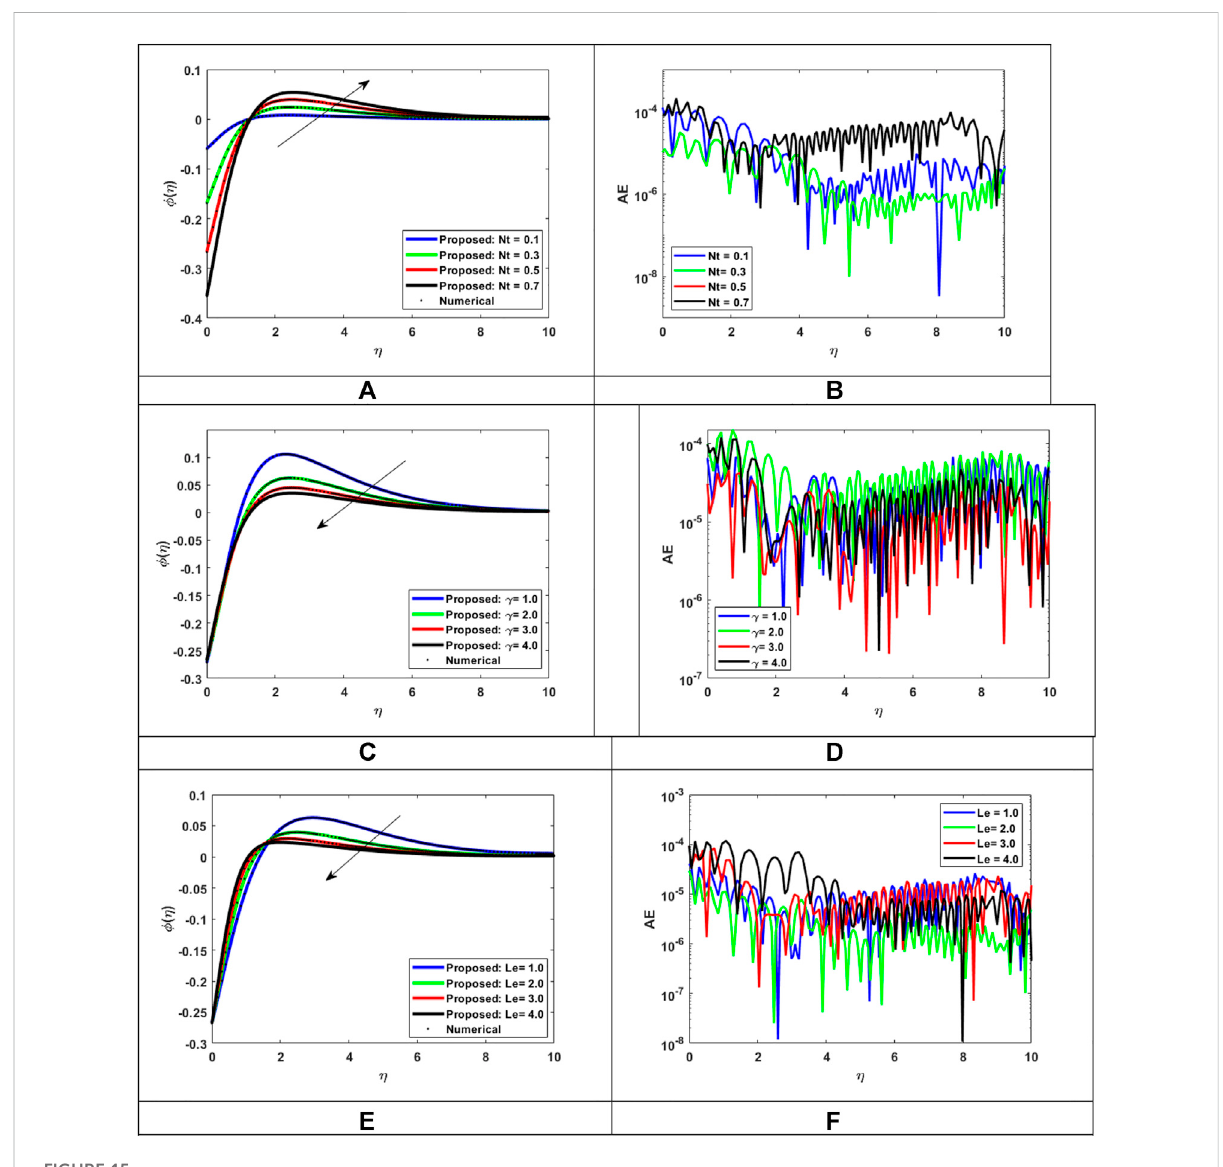
FIGURE 15 Assessment of LMLA-BPNN along the reference dataset of MHD-WNF-HGA. (A) Variation of N t for ϕ ( η ) , (B) AE for MHD-WNF-HGA, (C) Variation of γ for ϕ ( η ) , (D) AE for MHD-WNF-HGA, (E) variation of L e for ϕ ( η ) , (F) AE for MHD-WNF-HGA.